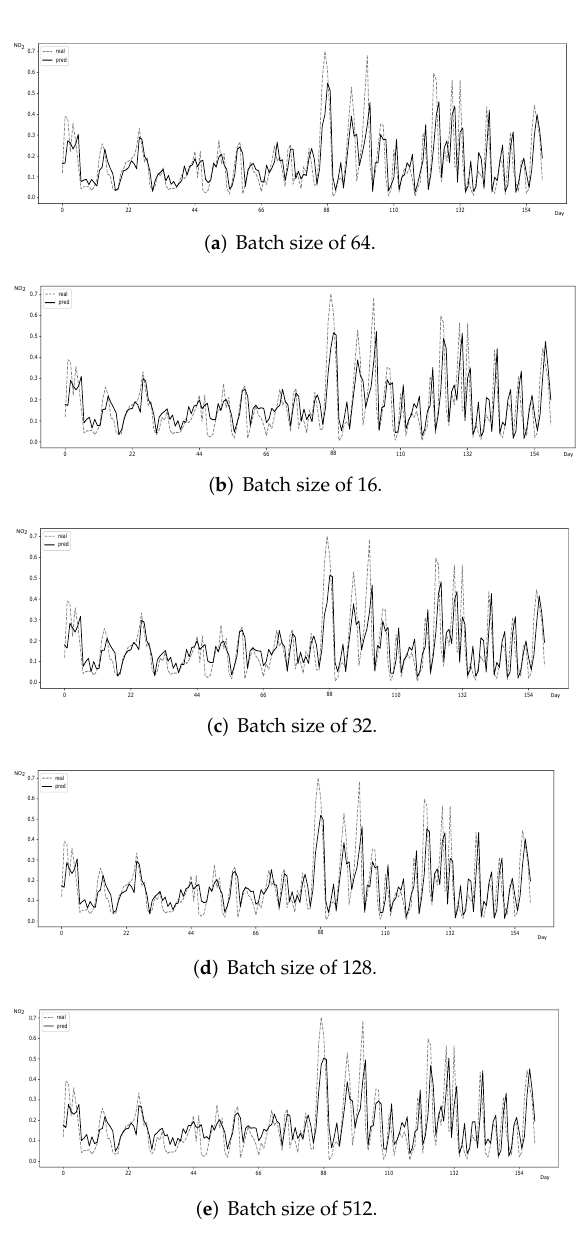
( e ) Batch size of 512. Figure 17. Predicted vs. actual normalized output values with changes in the batch